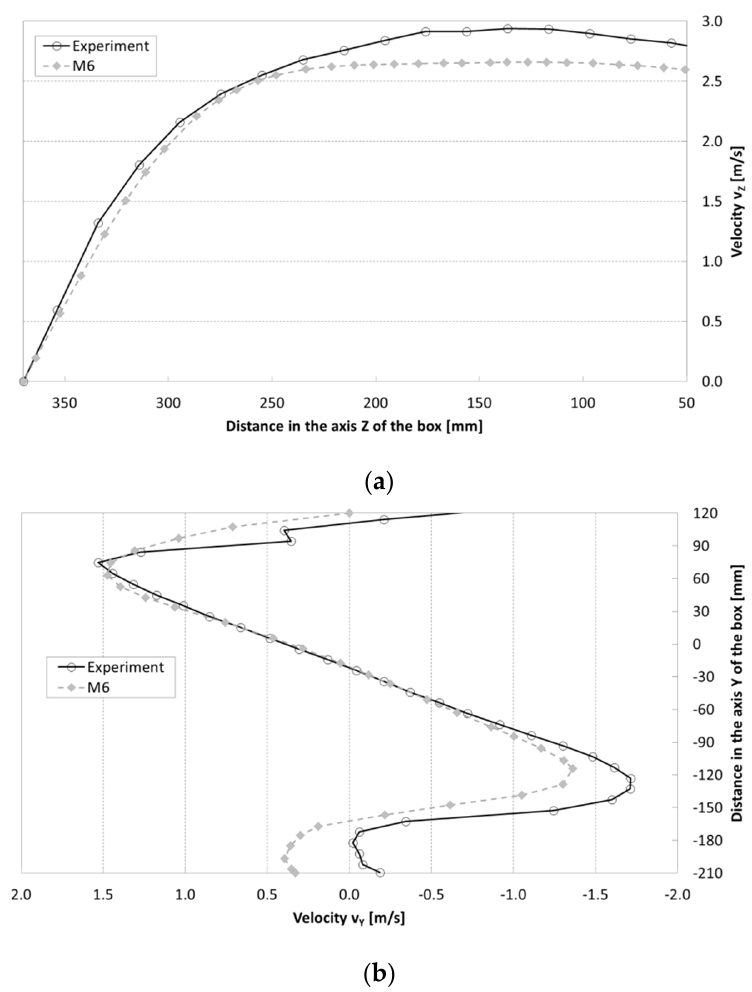
Figure 14. The comparison of v z and v y velocity components distribution in plenum box with side entry, between numerical results and experimental results, ( a ) in the Z direction for Y = 0 mm; ( b ) in the Y direction for Z = 350 mm.